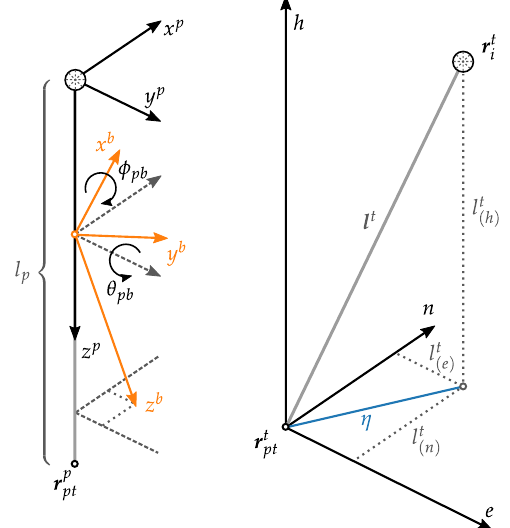
Figure 2. ( left ) The IMU body frame ( b ) and the pole frame ( p ) related by the mounting parameters φ pb and θ pb . ( right ) Visualization of the tilted pole and the components of the pole vector in the t-frame . Including the horizontal displacement η due to tilting in blue, compare Figure